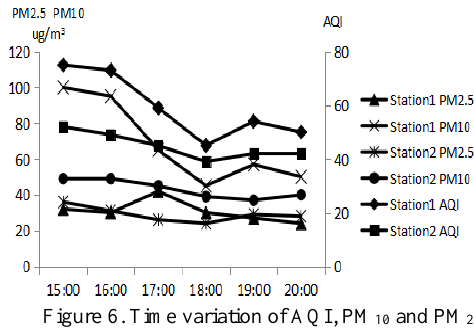
Figure 6. Time variation of AQI, PM 10 and PM 2.5